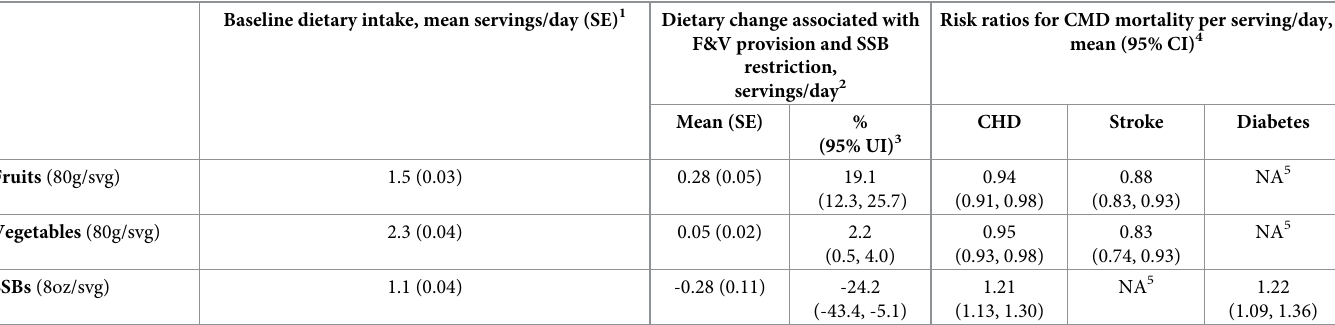
Table 2. Select model inputs for modeling CMD outcomes in adults. Baseline dietary intake, mean servings/day (SE)